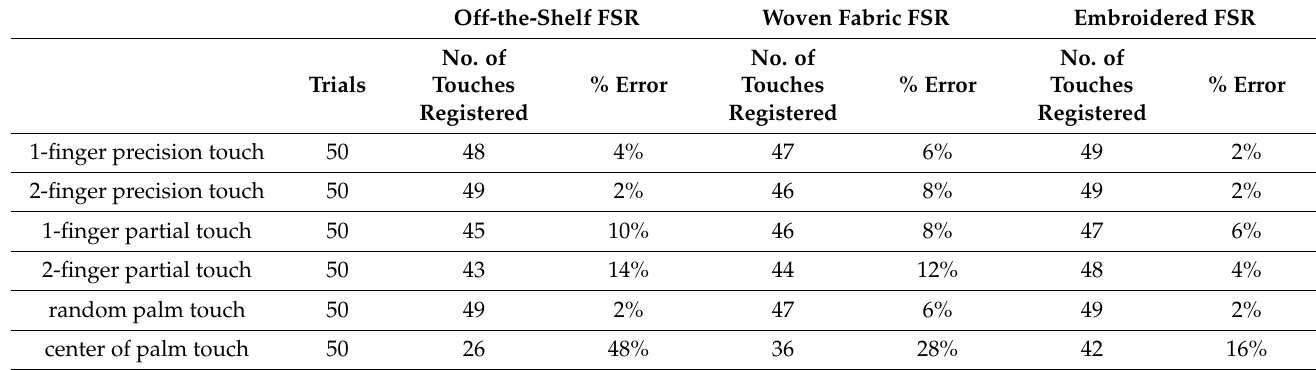
Table 5. Error calculation for different touch patterns.